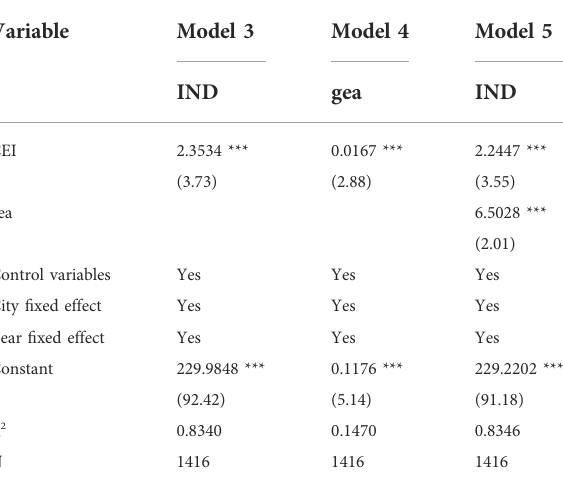
TABLE 4 Mechanism